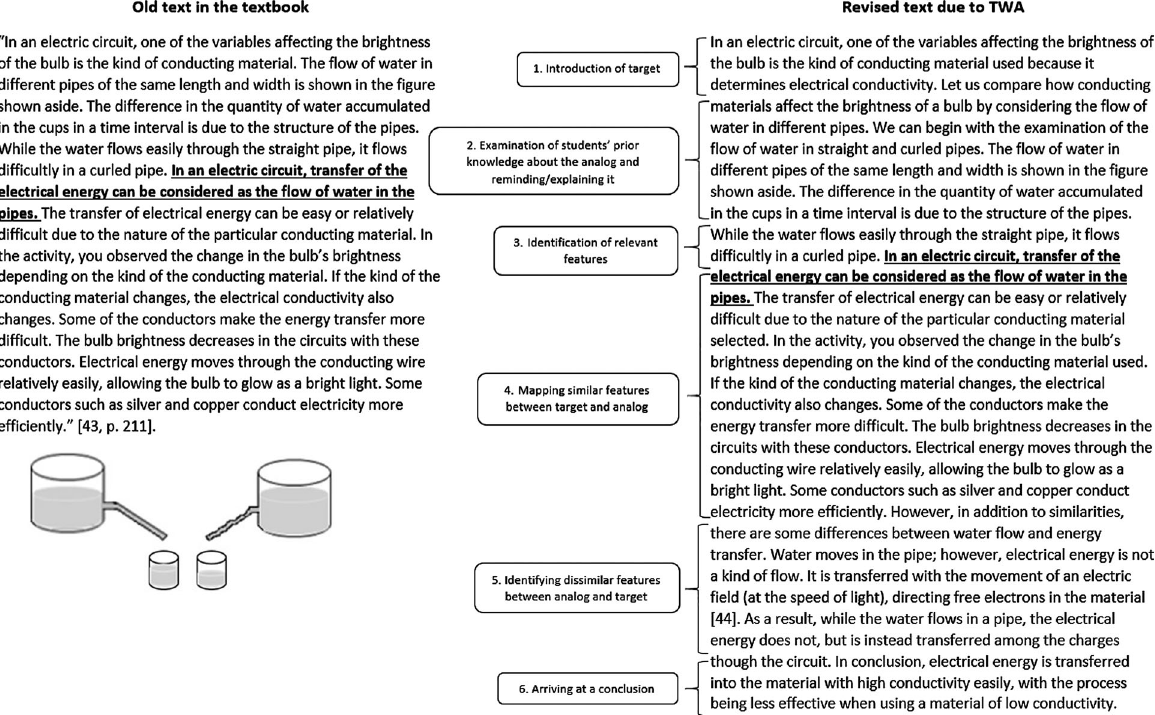
FIG. 4. Revised version of the analogy used in the 6th grade textbook [43] (p. 211) due to TWA. The textbook is originally in Turkish and the analogy was presented with tub figures. So the text explaining the analogy was translated and the tub figures were redrawn similar to the ones given in the